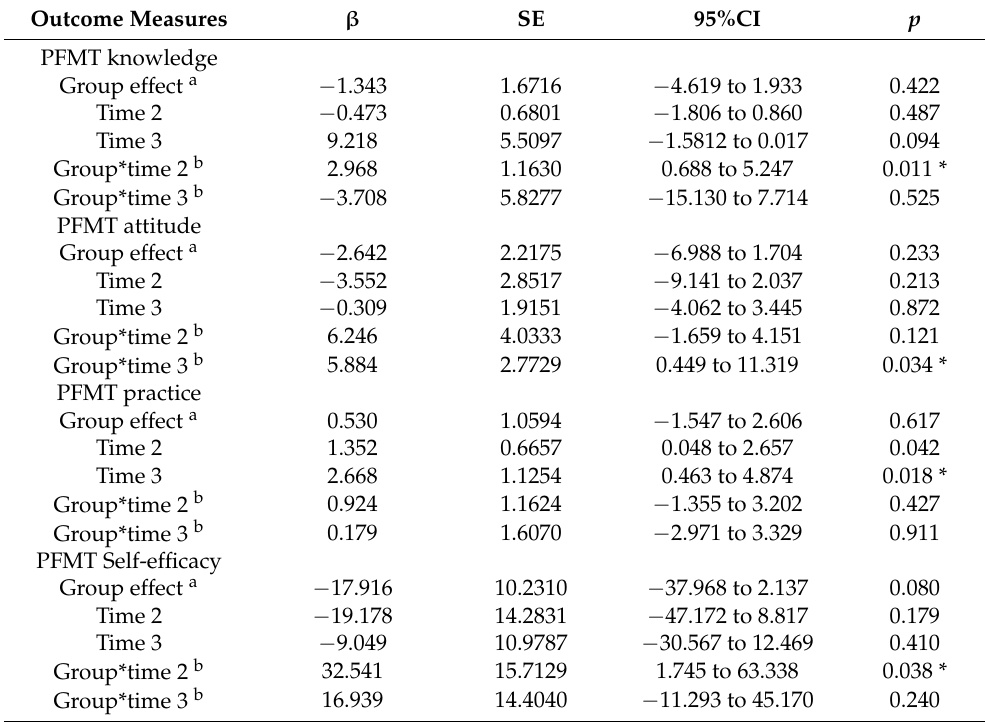
Table 6. The effect of KEPT app on PFMT knowledge, attitude, practice, and self-efficacy.